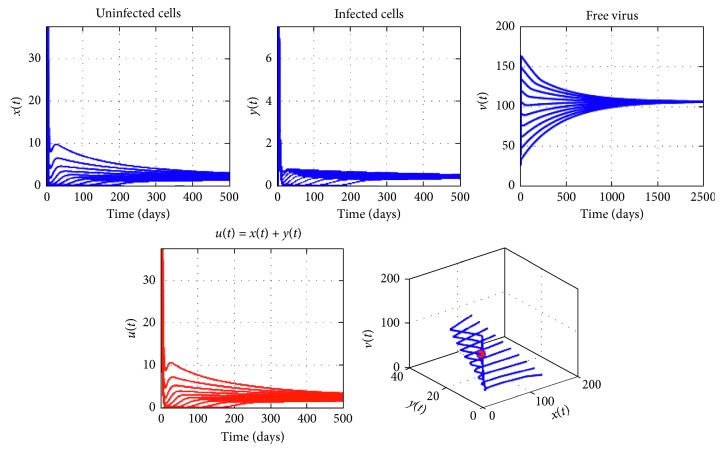
Dynamics of virotherapy when R0=1,5, β0=10−5, β1=10−4, and τ=10 > τ∗=8.8368. The initial conditions are x(0)=127, y(0)=0, and v(0)=30.